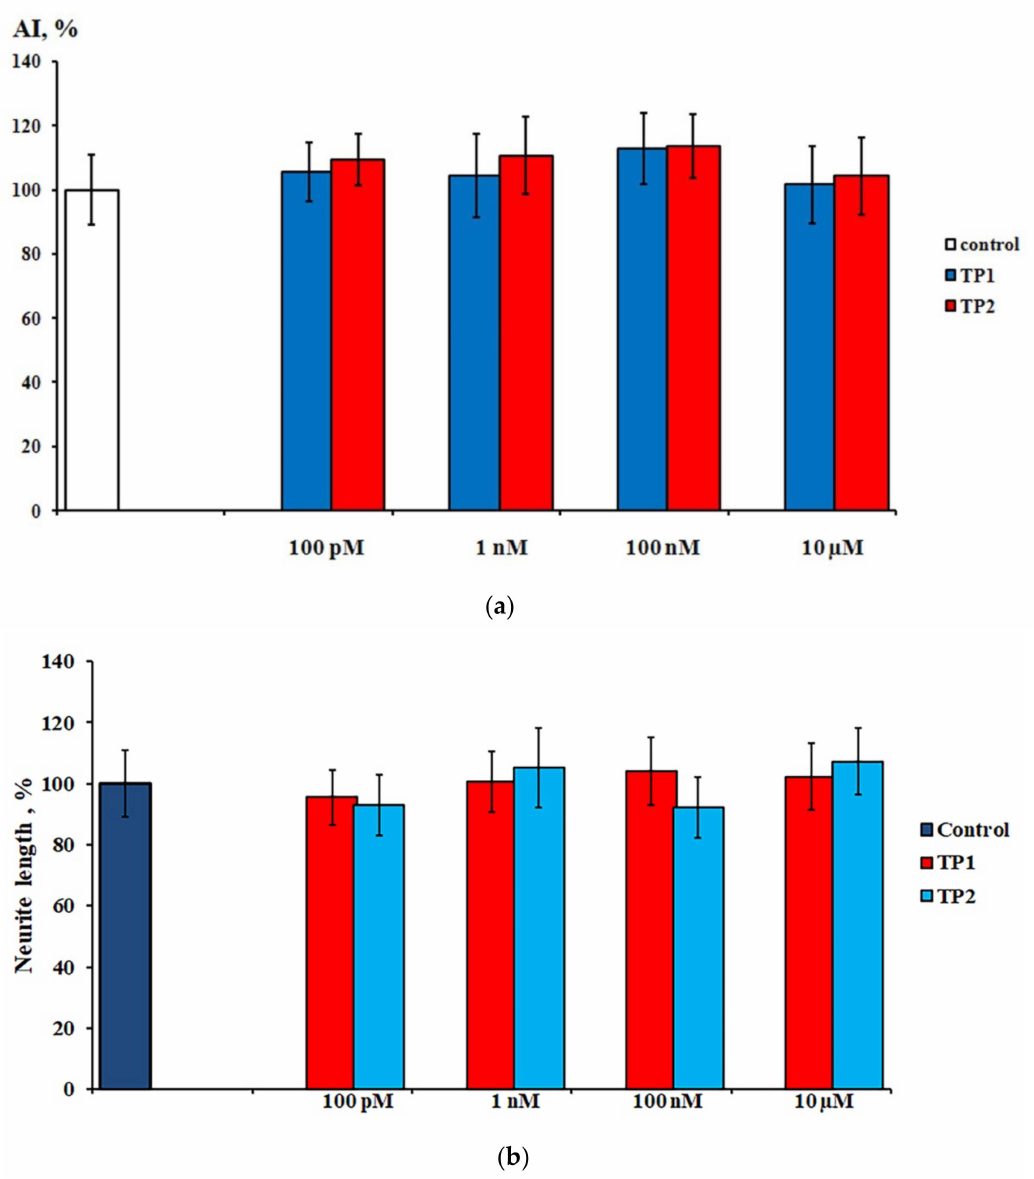
Figure 5. Effects of TP1 and TP2 on neurite growth in DRG explants. ( a )—DRG area index values. The ordinate axis–area index (AI, %). Data are presented as mean ± SEM ( n = 25 for each concentration; not significant, p > 0.5). ( b )—DRG neurite length values. The ordinate axis–neurite length (%). Data are presented as mean ± SEM ( n = 25 for each concentration; not significant, p >